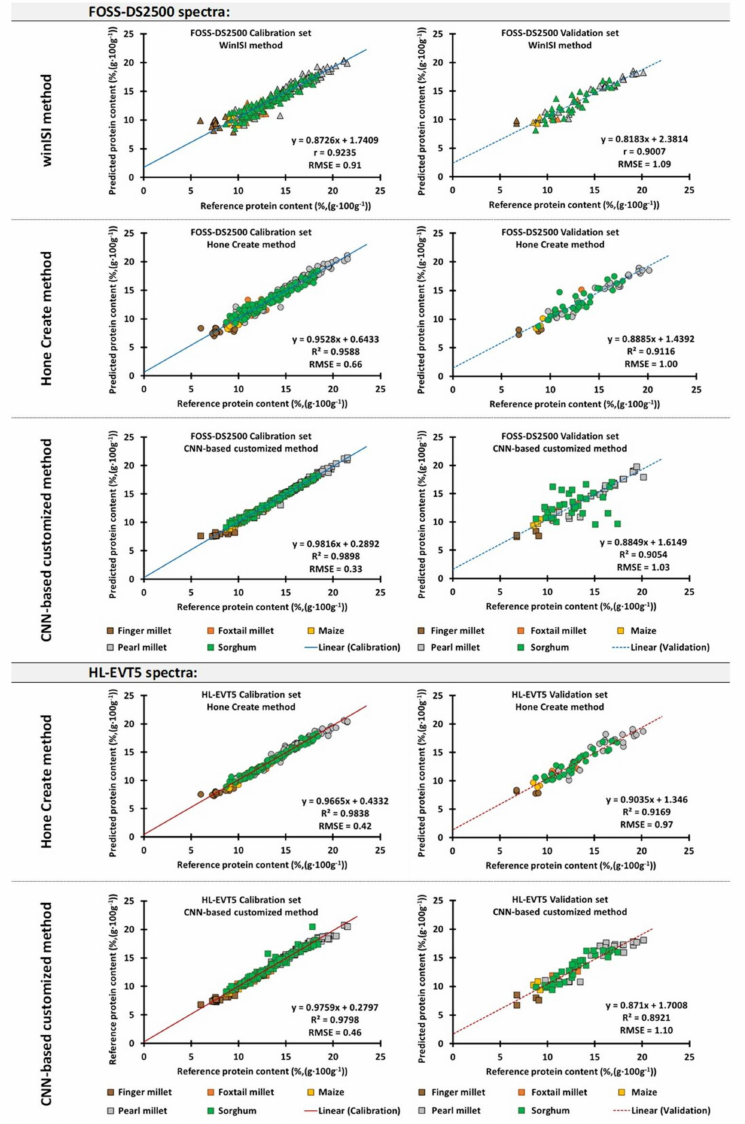
Figure 6. Matrix of scatter plots showing protein predicted for the calibration and validation datasets of FOSS-DS2500 and HL-EVT5 via methods available in (I) WinISI software, (II) Hone Create soft- ware, and (III) CNN-based customized method. Detailed metrics for comparison with other methods are shown in Table